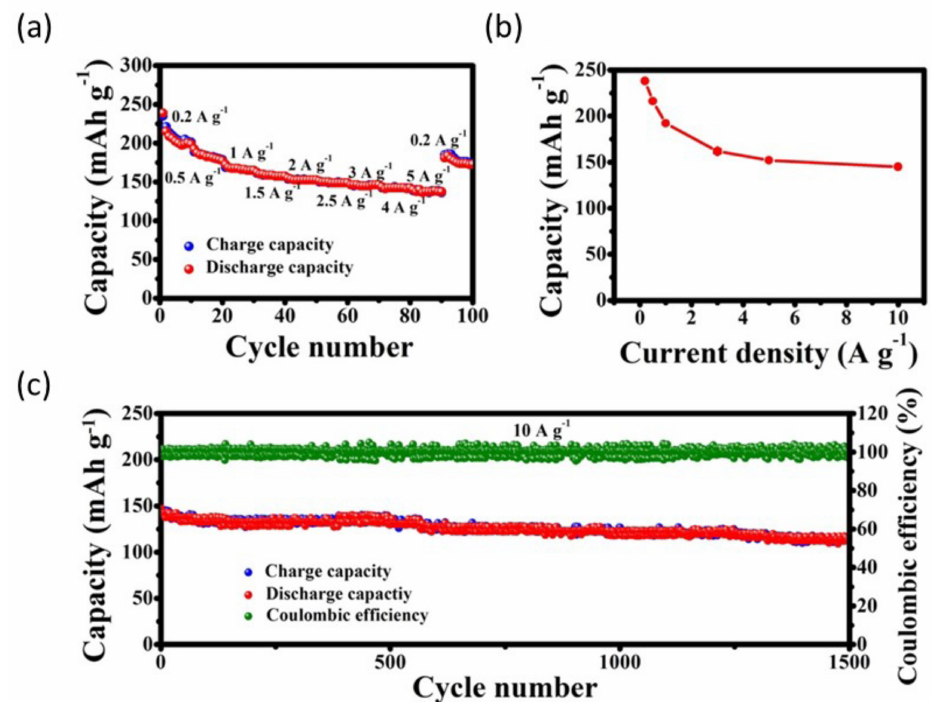
Figure 10. Electrochemical performance of the t-CNTs–PA–PE cathode in ZIBs. ( a , b ) Rate perfor- mance, and ( c ) cyclic performance at 10 Ag − 1 . Reprinted with permission from Ref. [75]. Copyright 2019 American Chemical